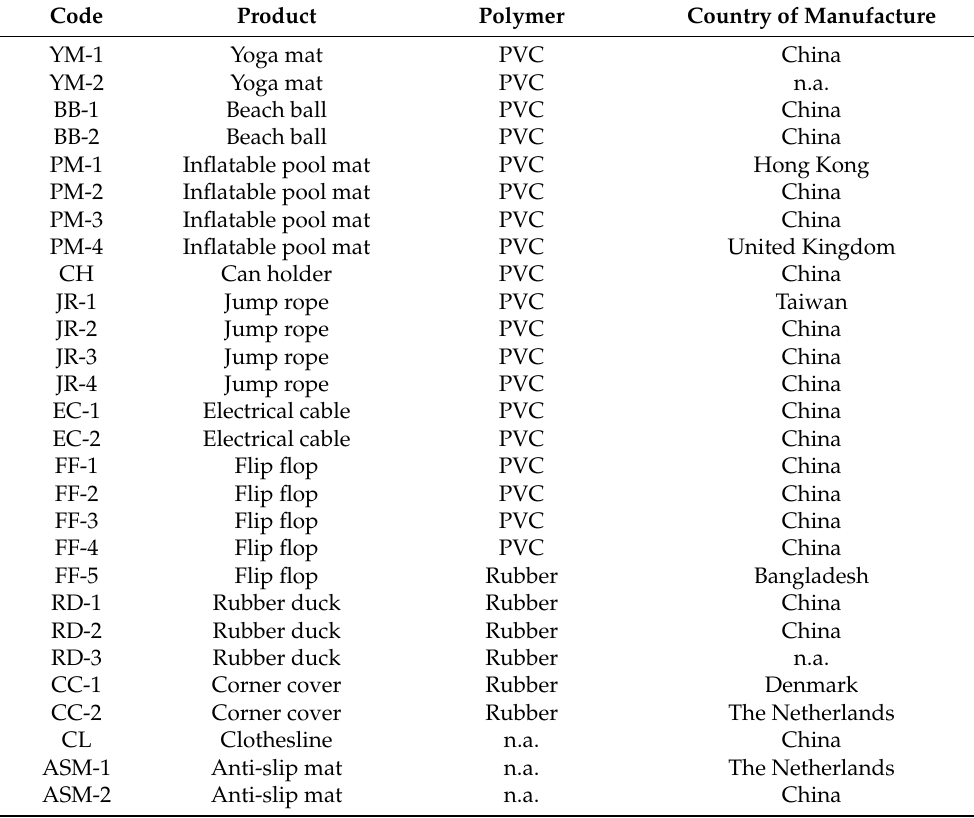
Table 1. Consumer product and toy sample